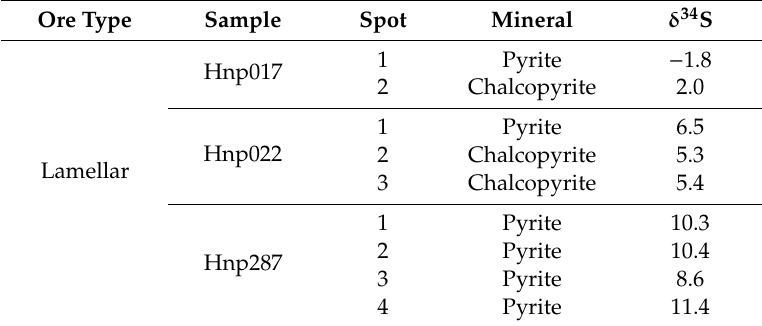
Table 4. Sulfur isotope compositions (% (cid:24) ) of sulfides analyzed in this